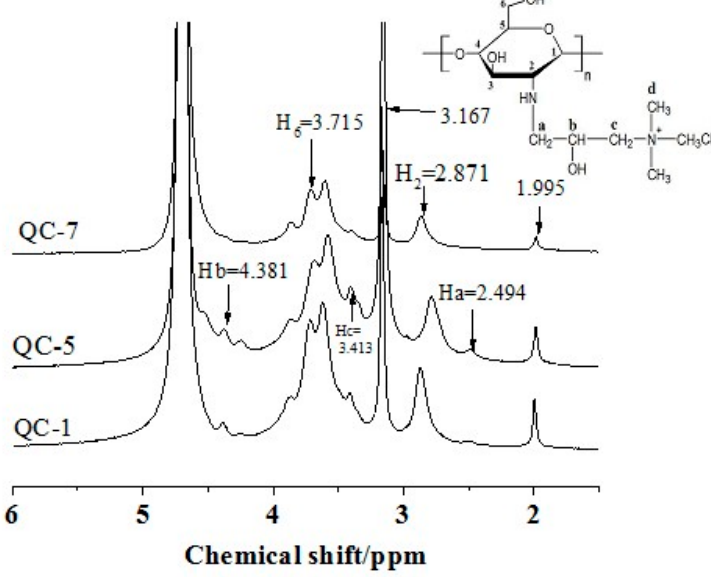
Figure 2. 1 H NMR of QC-1, QC-5 and QC-7.